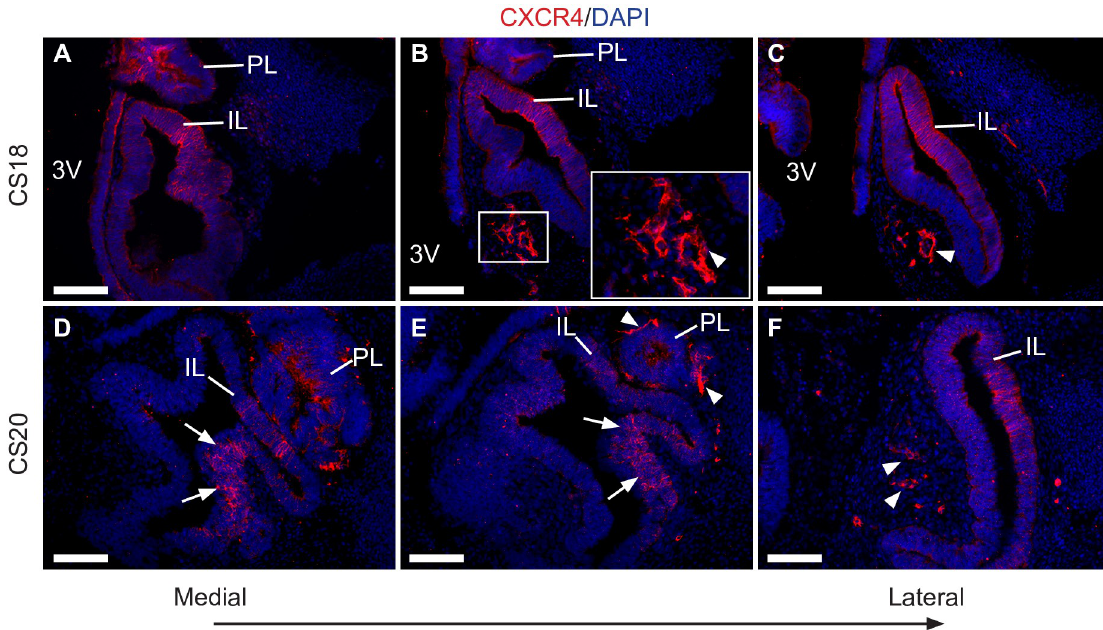
Fig 2. The expression pattern of CXCR4 at different stages of human embryonic pituitary development. (A-C) Immunofluorescent staining for CXCR4 at CS18 shows positive cells are found throughout the dorsomedial region of Rathke’s Pouch (prospective intermediate lobe). CXCR4+ cells are also observed in the developing infundibulum (prospective posterior lobe). Strong positive signal is observed in cells surrounding luminal structures located ventrally and laterally to the future anterior lobe (arrowheads). (D-F) A similar expression pattern is observed at CS20, with strong CXCR4 expression in the postero-dorsal region of RP (arrows) and in elongated cells located in lateral regions (arrowheads). Counterstain is DAPI. Scale bars: 100 μ m. IL; Intermediate lobe; PL: Posterior Lobe; 3V: Third ventricle.